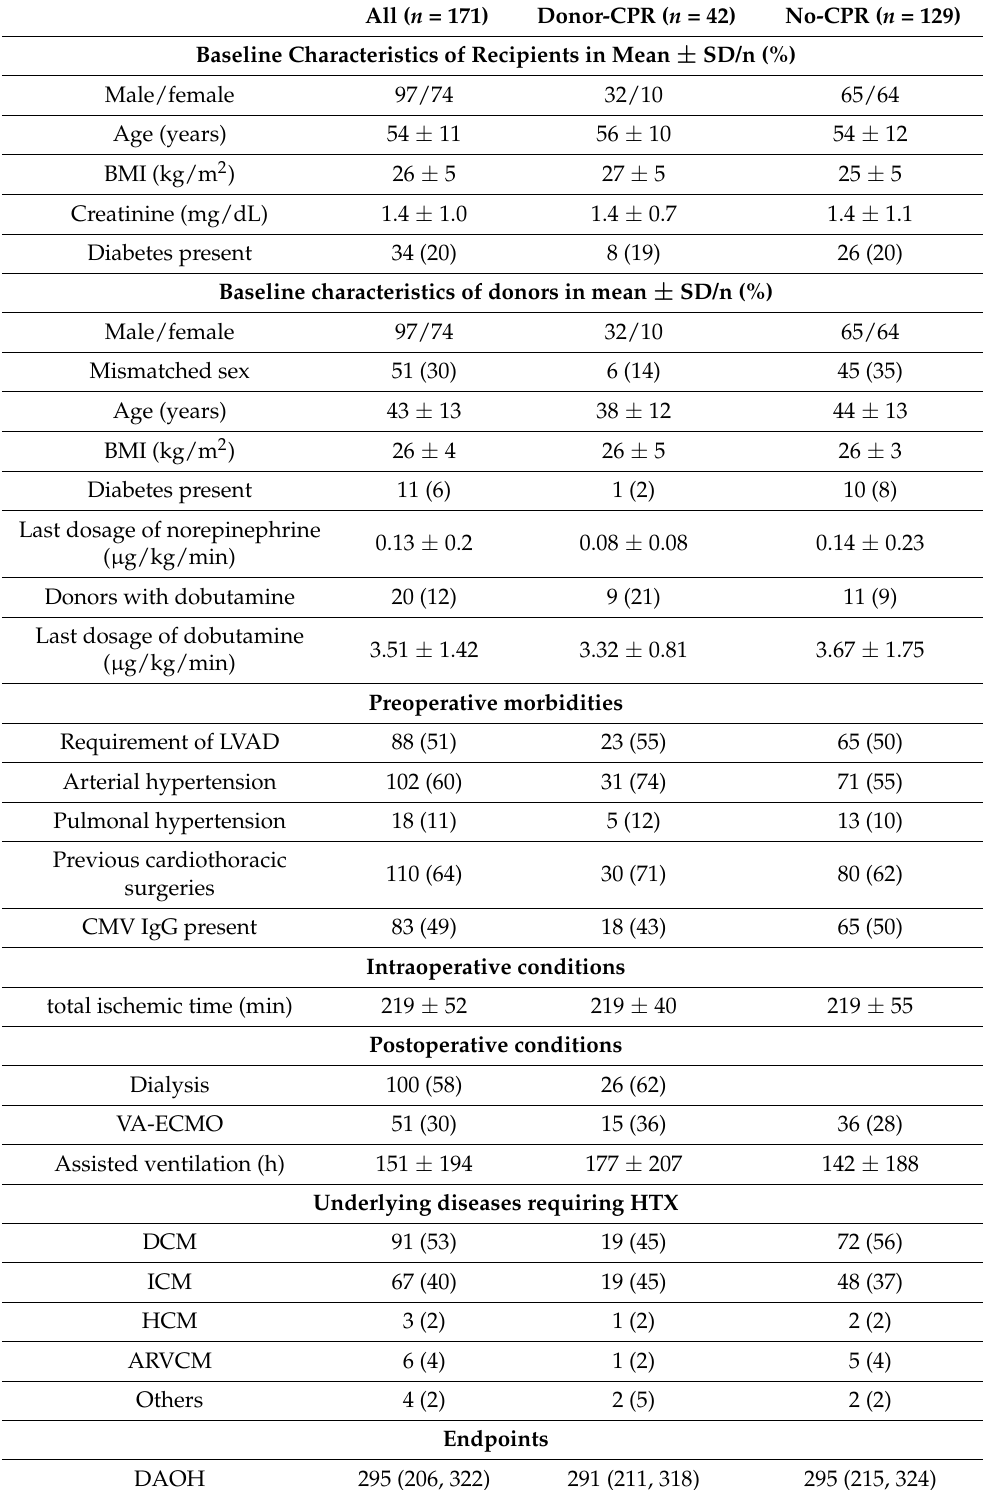
Table 1. Patient